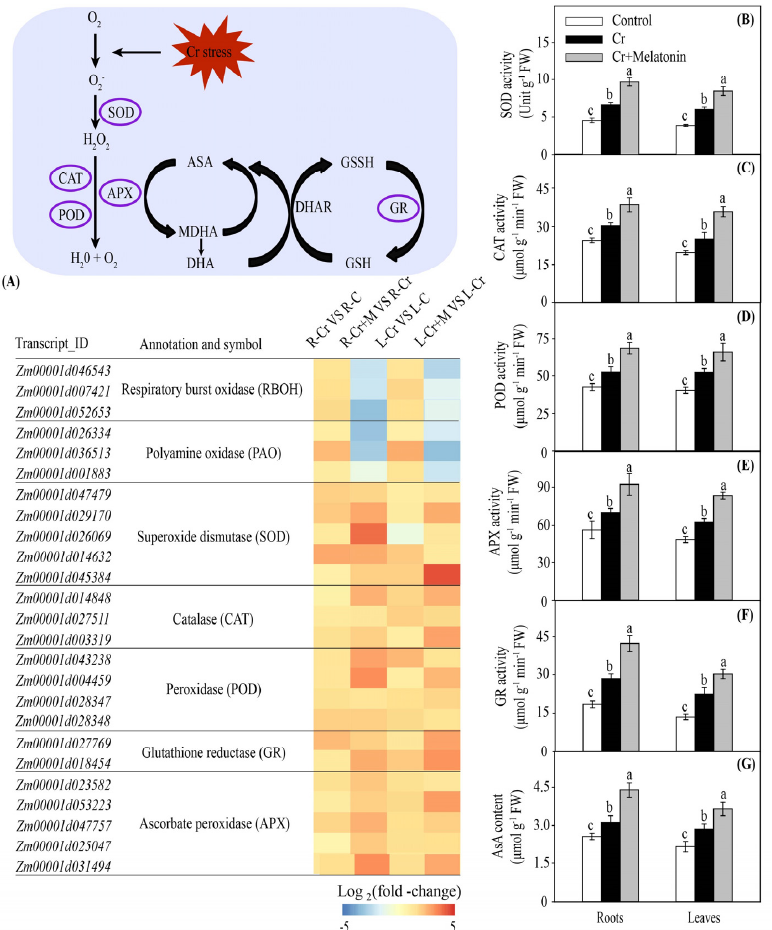
Figure 6. Melatonin and Cr induced transcript changes of genes in antioxidant enzyme biosynthesis in maize roots and leaves ( A ). The color scale represents log 2 (fold-change). The effect of melatonin on superoxide dismutase (SOD) activity ( B ), catalase (CAT) activity ( C ), peroxidase (POD) activity ( D ), ascorbate peroxidase (APX) activity ( E ), glutathione reductase (GR) activity ( F ), and ascorbate (AsA) content ( G ) in maize roots and leaves during Cr stress. Different letters in one measure (roots or leaves) denote significant differences at p < 0.05. Data are shown as mean ± SE ( n =